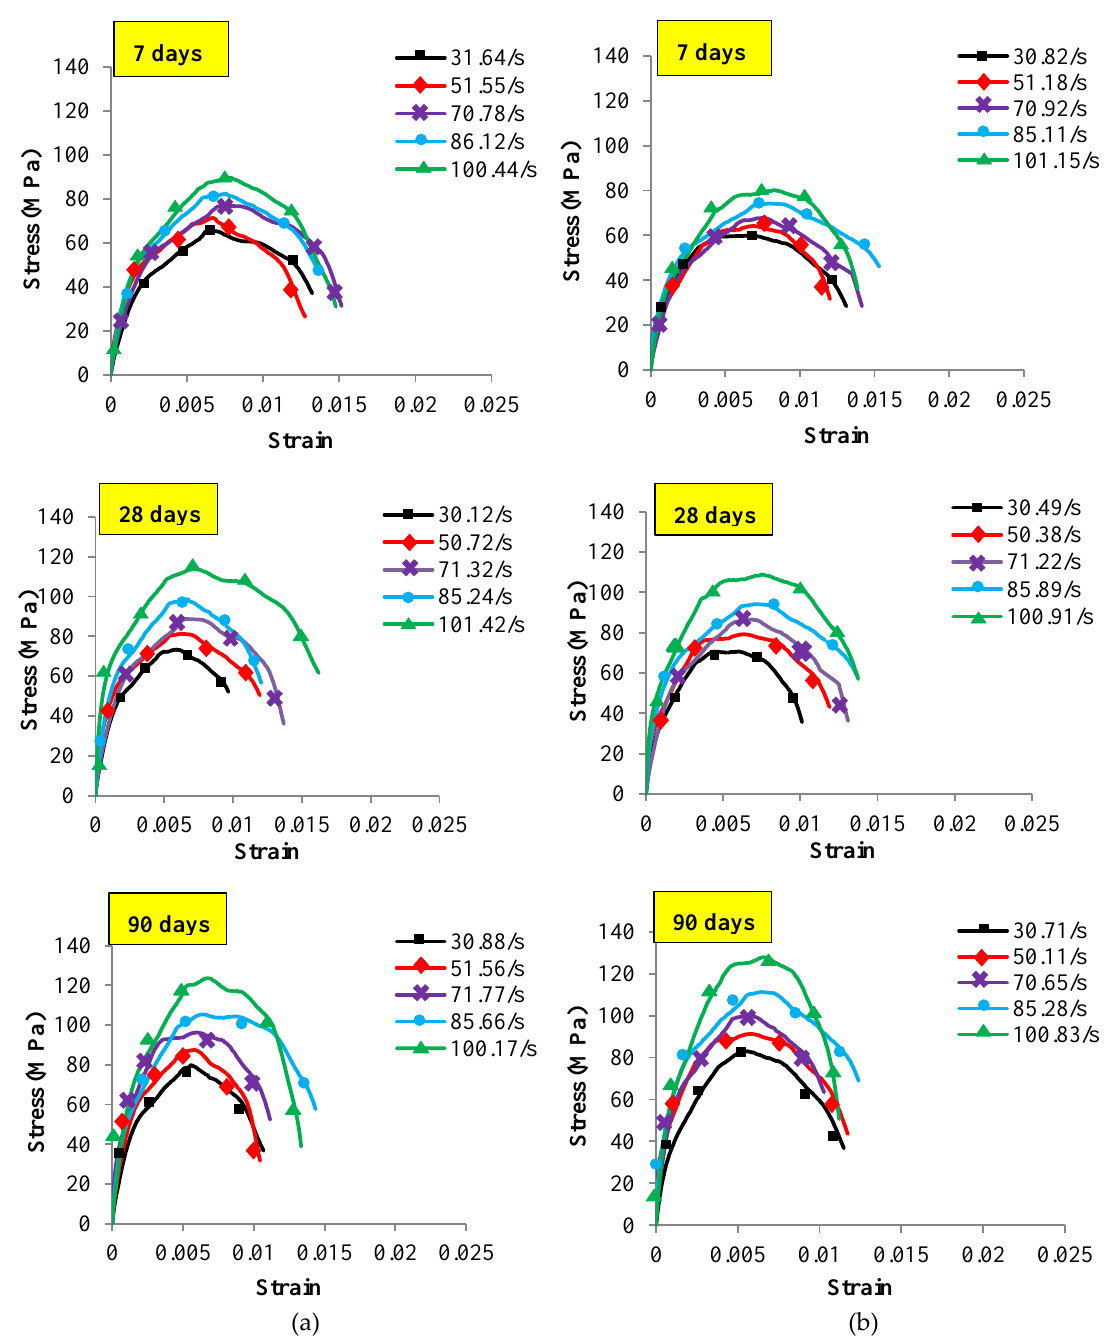
Figure 5. Stress–strain diagrams at 25 °C: ( a ) PC and ( b ) HVFANS concrete